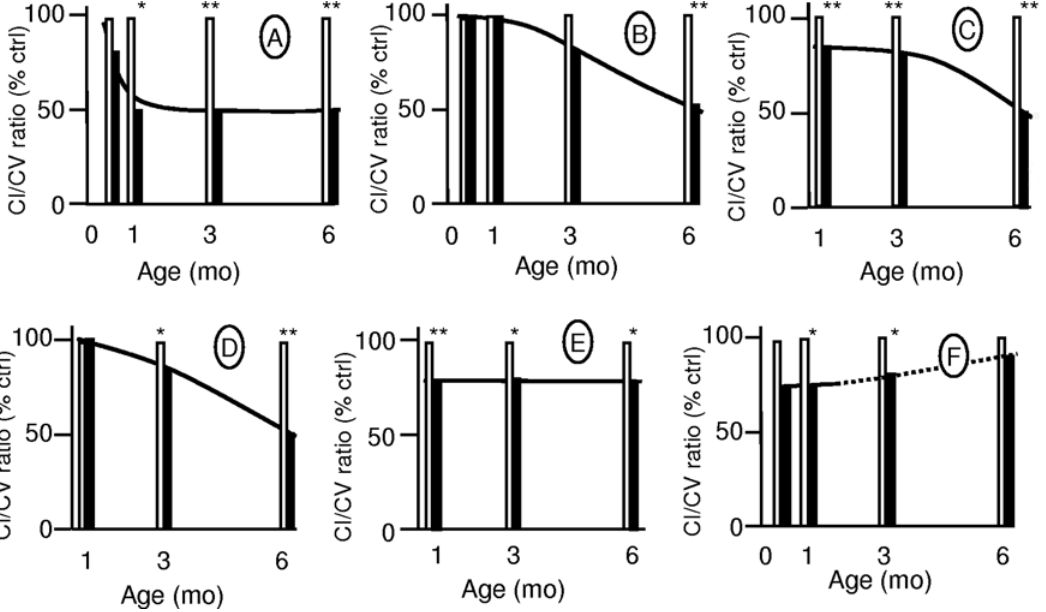
Figure 5. Differences in the time-course and severity of complex I deficiency across tissues from Harlequin mice. A–F: Complex I activity in homogenates prepared from cerebellum (A), thalamus (B), cortex (C), optic nerves (D), skeletal muscle (E), and retinas (F). Complex I activity was measured by spectrophotometry [40] and normalized for the activity of complex V, which was not affected by Aif depletion. The open and dark symbols refer to the control and Hq mice, respectively. Continuous lines indicate changes in complex I activity over time in various tissues of Hq mice. The dotted line indicates changes in complex I activity over time in Hq retinas, presumably ascribed to biased sample collection. Numbers of animals were as follows: 15 d of age, 3 controls and 3 Hq mice; 1 mo of age, 5 controls and 5 Hq mice; 3 mo of age, 5 controls and 5 Hq mice; 6 mo of age, 10 controls and 10 Hq mice. * p , 0.005; ** p , 0.001.